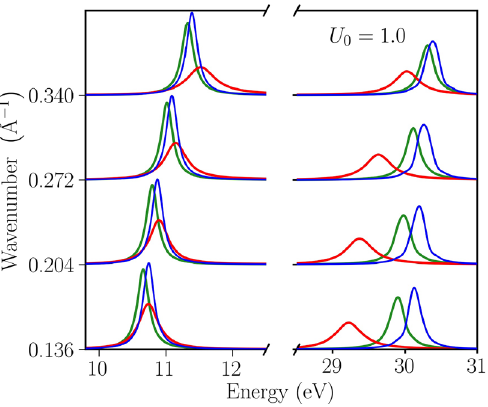
Figure 4. The emergence of a double-plasmon mode is observed at an angle of 45° to Q . The EELF is shown at a perturbation amplitude U 0 = 1.0 and for increasing temperature where solid blue denotes θ = 0.1 , solid green θ = 0.5 , and solid red θ = 1.0 . The double-plasmon feature exhibits a pronounced dependence on the temperature.